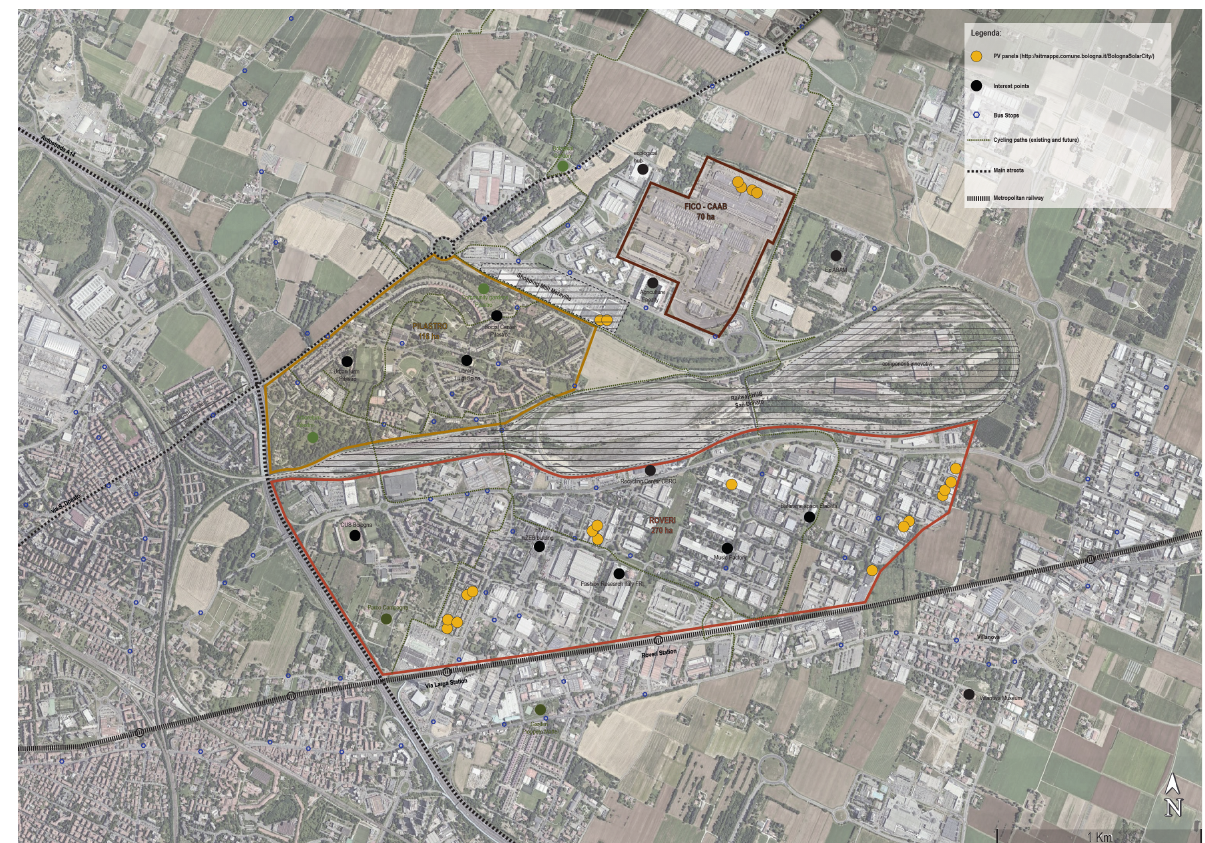
Figure 2. Image of the Pilastro-Roveri area. Infographic made by the